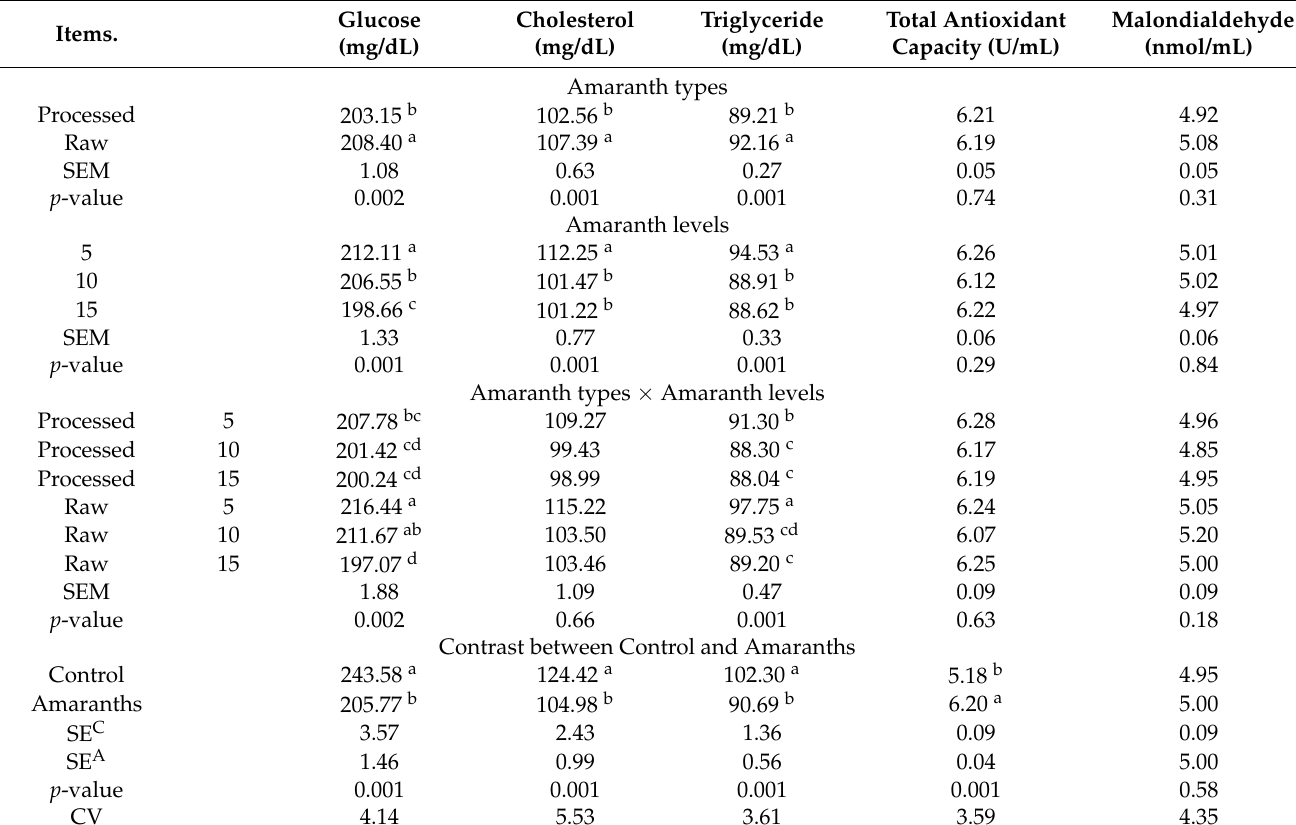
Table 5. Effect of trials diets on the blood biochemistry in laying